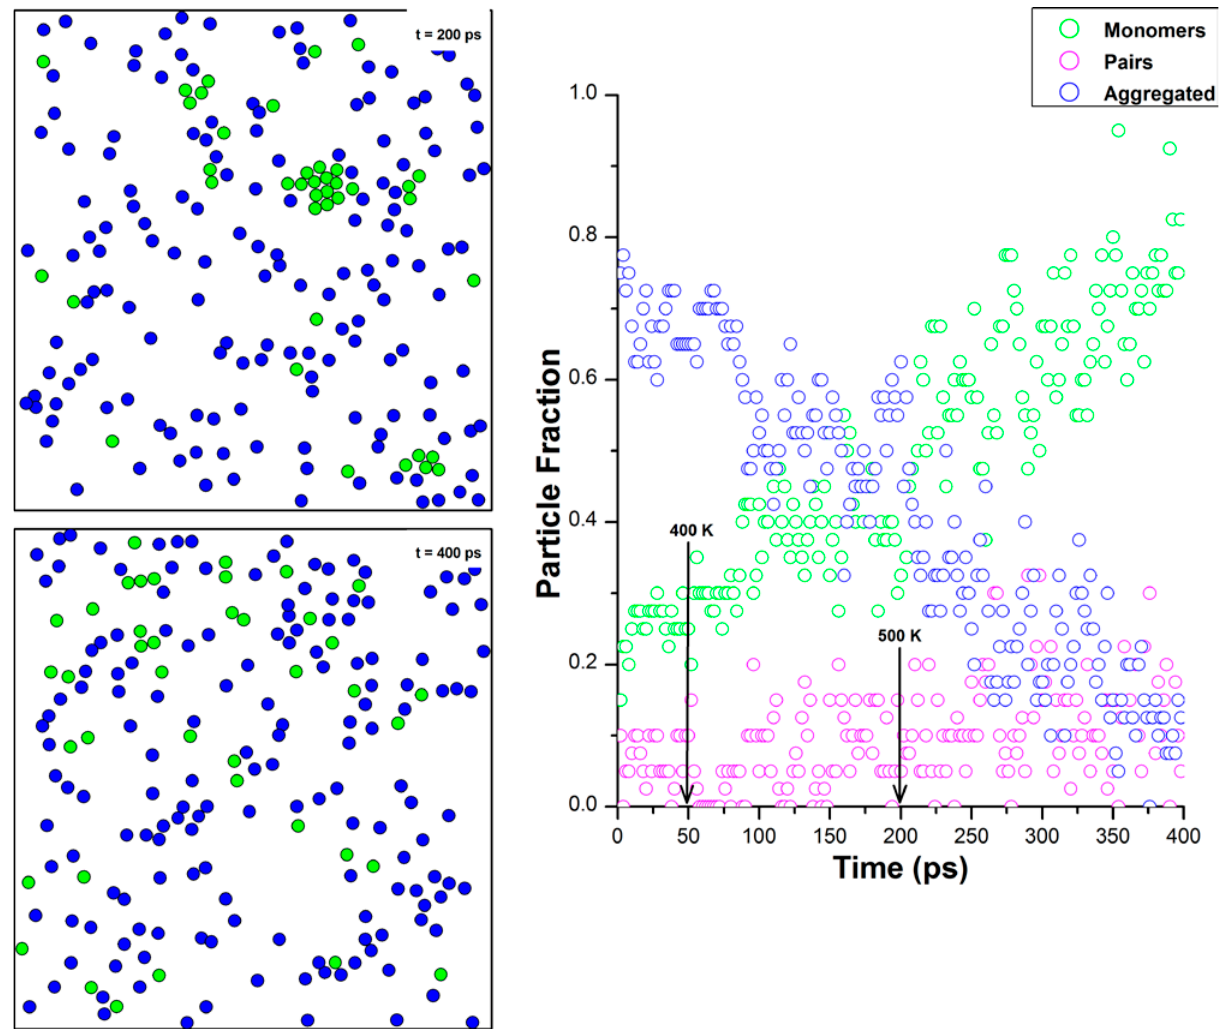
Figure 7. Left: snapshots of the configurations obtained after 200 ps (top) and after 400 ps (bottom) of a simulation started from the config- uration obtained after 400 ps at the conditions of Figure 5. The mixture was heated at T = 400 K (top) and T = 500 K (bottom). The interac- tion parameters (eV) were: ɛ A-A = 0.01, ɛ B-B = 0.1 and ɛ A-B = 0.05. Right: time evolution of the fraction of B monomers, pairs of B atoms and total aggregated B atoms present in clusters of more than 2 B atoms for the same simulation. The two arrows indicate the times when the temperature of the simulation was set to the specified values. The MD time step was 1